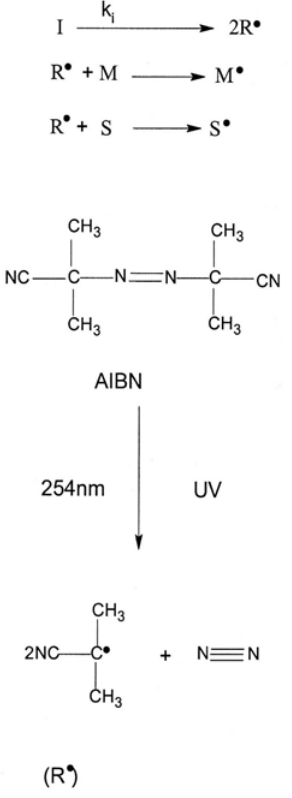
Figure 1. Formation of initiator radical.